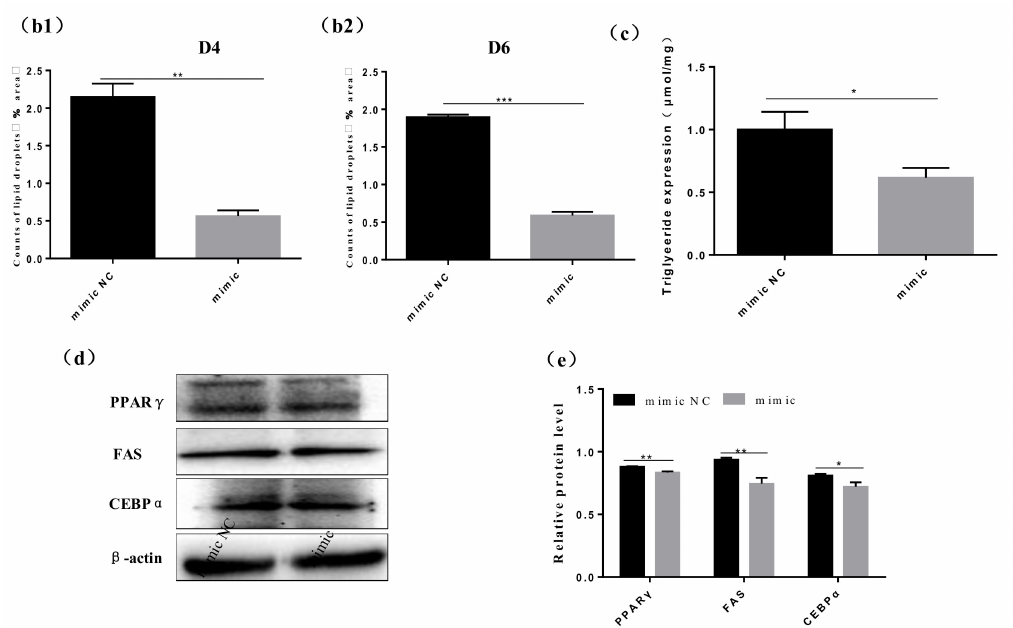
Figure 3. E ff ect of Bta-miR-376a on the morphology and gene expression of di ff erentiated bovine adipocytes. ( a1 – a4 ) Oil red O staining was performed on the bovine adipocytes on the d4 and d6 of di ff erentiation. The relative mRNA expression of adipogenic genes in the bovine adipocytes on the fourth and sixth day of di ff erentiation was used by Olympus Image taken by IX71 microscope (Olympus, Japan). ( b1 , b2 ) Image J software was used to count lipid droplets in bovine adipocytes on d4 and d6 of di ff erentiation. ( c ) The content of triglyceride was detected at 550 nm. ( d ) The adipogenesis genes of the bovine adipocytes transfected with bta-miR-376a mimic and mimic NC on d4 of di ff erentiation were analyzed by Western blot. ( e ) The quantitative analysis of PPAR γ , FAS, and CEBP α was performed by Western blotting. Data are expressed as mean ± SEM, * p ≤ 0.05, ** p ≤ 0.01, *** p ≤